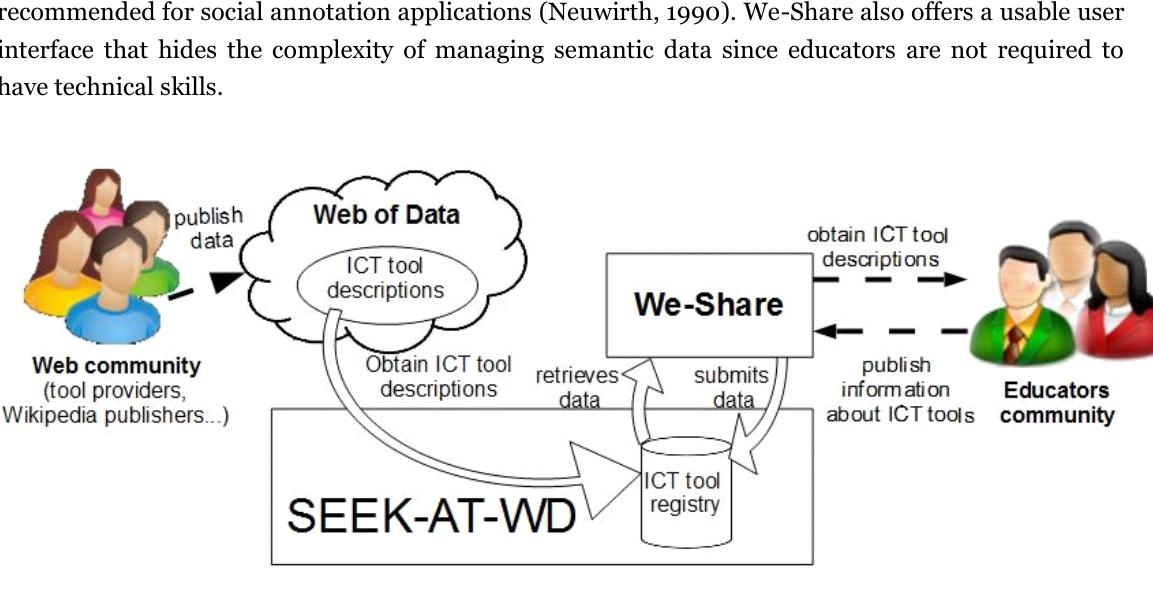
Figure 1. We-Share as a social-semantic annotation application that enables educators to publish and retrieve information about tools from the Web of